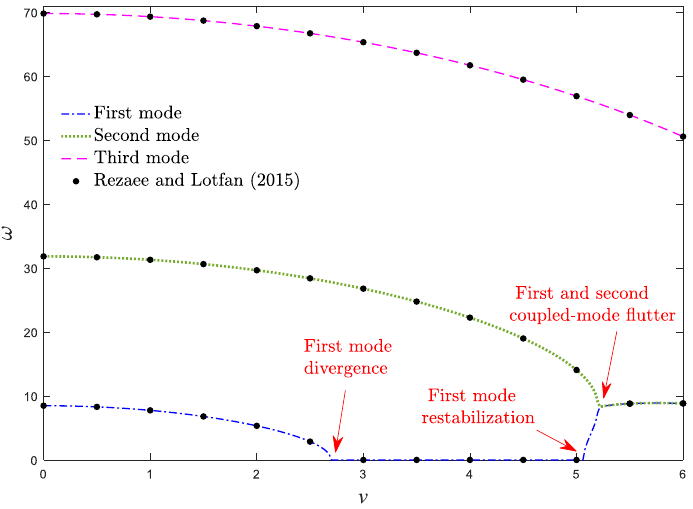
Figure 4. Real parts of the first three dimensionless vibrational frequencies of an axially moving isotropic nanobeam against the dimensionless velocity for µ = 0.025, k f = 0.8, ζ = 0.